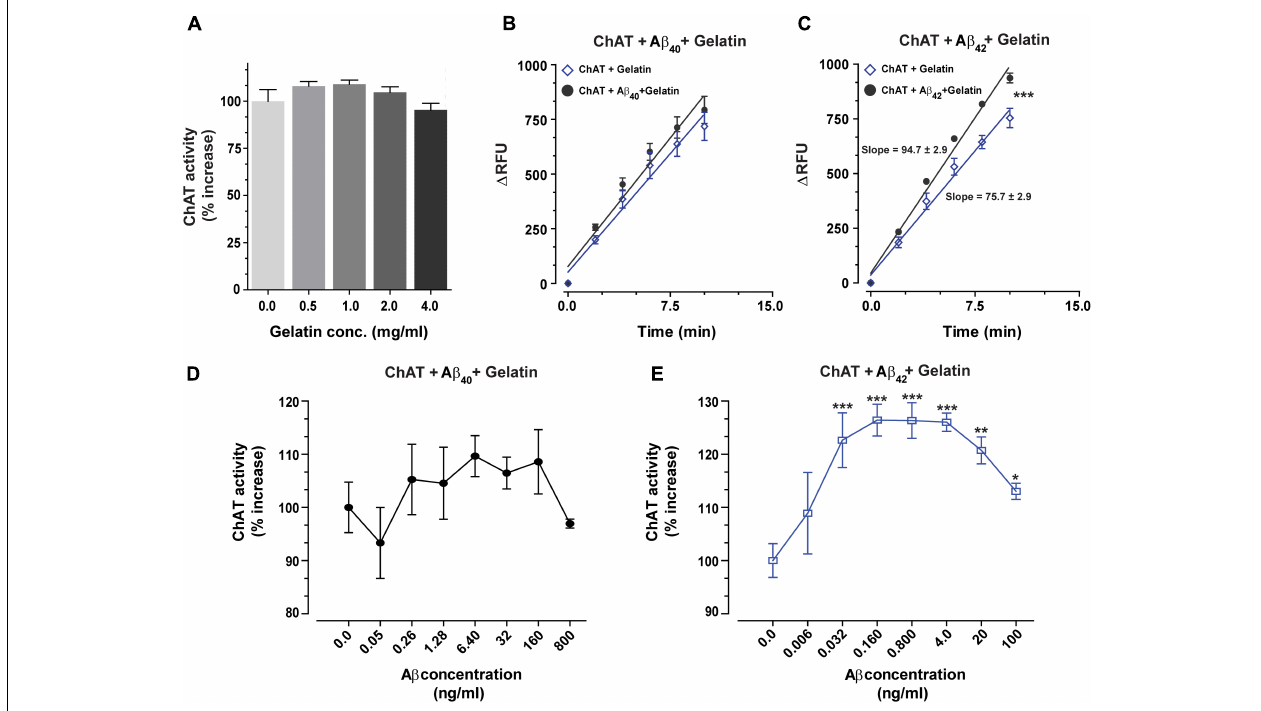
FIGURE 4 | The enhanced catalytic rate of ChAT by A β 42 is specific. (A) To demonstrate that A β -enhanced ChAT activity is a specific phenomenon, ChAT activity was first monitored at various concentrations of gelatin, ranging from 0 to 4 mg/mL. The result indicated that gelatin had no significant effect on ChAT activity. The values are shown as mean ± SD of four readings. (B) The kinetic rate of ChAT activity ( (cid:49) RFU/min) was measured in the presence of gelatin alone (1 mg/mL) as a control and gelatin+A β 40 (6.4 ng/mL). Although analyses of the slopes were not statistically significant, the comparison of the elevations or intercepts was significant ( F = 9.2, p < 0.004). (C) Then the kinetic rate of ChAT activity ( (cid:49) RFU/min) is shown in the presence of gelatin alone (control) and gelatin+A β 42 (0.16 ng/mL). In this case, the differences in the slopes were statistically highly significant ( F = 21, ∗∗∗ p < 0.0001). The analyses of the slopes were done by using linear regression function in GraphPad Prism 7. The values are shown as mean ± SD of ≥ 2 readings. (D) Illustrates the percent changes in the ChAT activity in presence of gelatin (1 mg/mL) plus increasing concentrations of A β 40. (E) Shows the corresponding percent changes in the ChAT activity in presence of gelatin (1 mg/mL) plus increasing concentrations of A β 42. The symbols ∗ , ∗∗ , and ∗∗∗ represents p -values < 0.03, < 0.001, and < 0.0005, respectively, relative to the control (no A β ). The comparisons are based on one-way ANOVA analysis and Fisher’s LSD post hoc